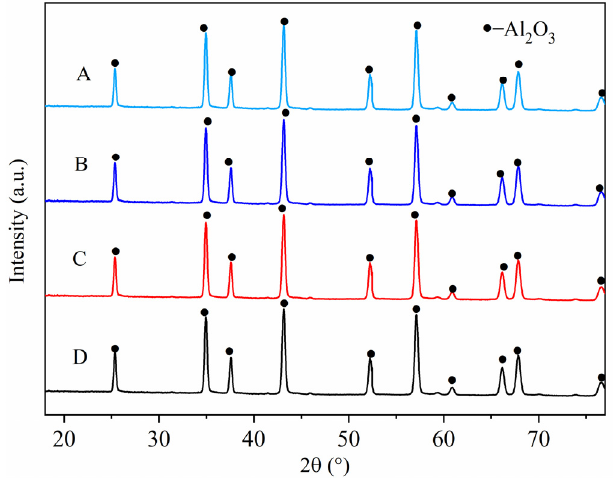
Figure 4. XRD patterns of the samples sintered at 1550 °C, composed of ( A ) 20 vol.% pore-forming agents + 80 vol.% alumina, ( B ) 30 vol.% pore-forming agents + 70 vol.% alumina, ( C ) 40 vol.% pore-forming agents + 60 vol.% alumina, and ( D ) 50 vol.% pore-forming agents + 50 vol.% alumina.